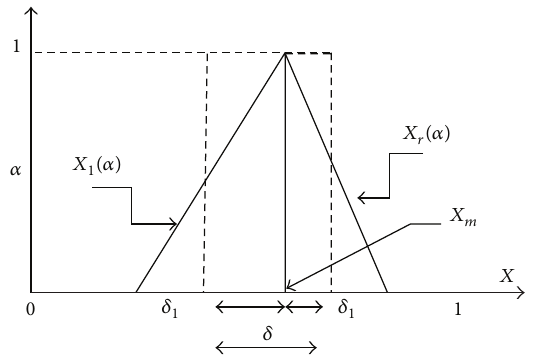
Figure 4: Deviation of mean for a fuzzy